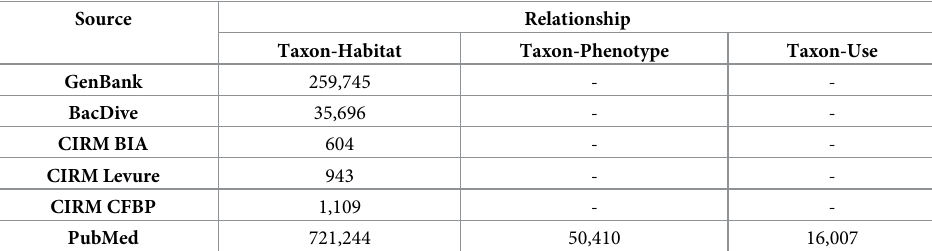
Table 3. Number of distinct relationships extracted per source in the May 2022